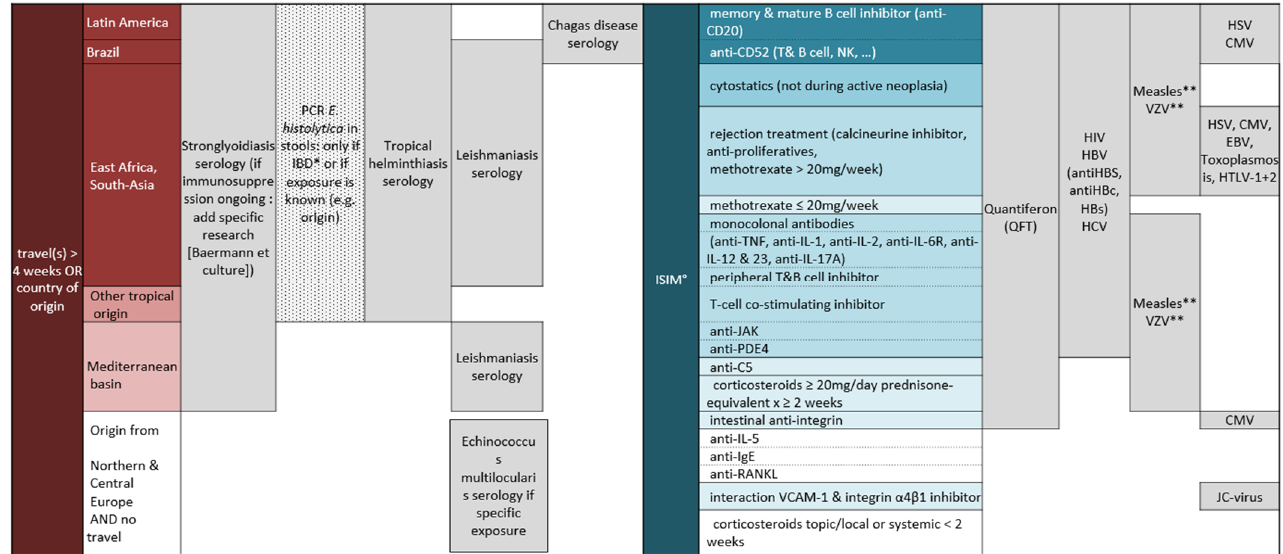
Figure 1. Screening algorithm according to travel exposition and type of immunosuppression × ; × The algorithm was adapted from Eperon et al., RMS 2018, 14: 922–933; * IBD: inflammatory bowel disease; ◦ ISIM: immunosuppressive and immunomodulatory agents; ** If negative, vaccinate before immunosuppression. QFT: Quantiferon; HIV: Human immunodeficiency virus; HBV: Hepatitis B virus; HCV: Hepatitis C virus; VZV: Varicella-zoster virus; HSV: Herpes simplex virus; CMV: Cytomegalovirus; EBV: Epstein–Barr virus; HTLV-1: human T-cell lymphotropic virus type 1; JC-virus: John Cunningham virus.